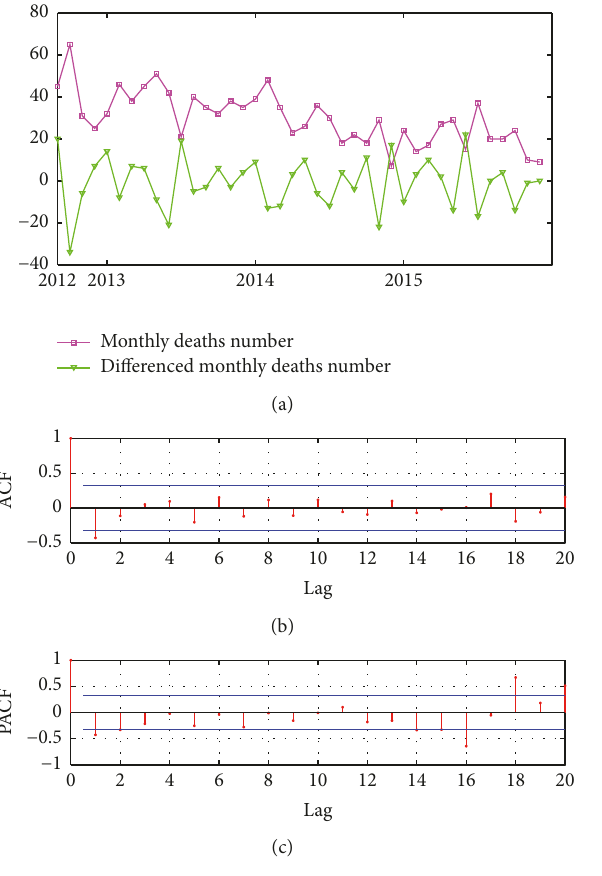
Figure 4: (a) Monthly number of injuries is plotted against its first differenced series, acf (b) and pacf (c) plots for the first difference in monthly number of